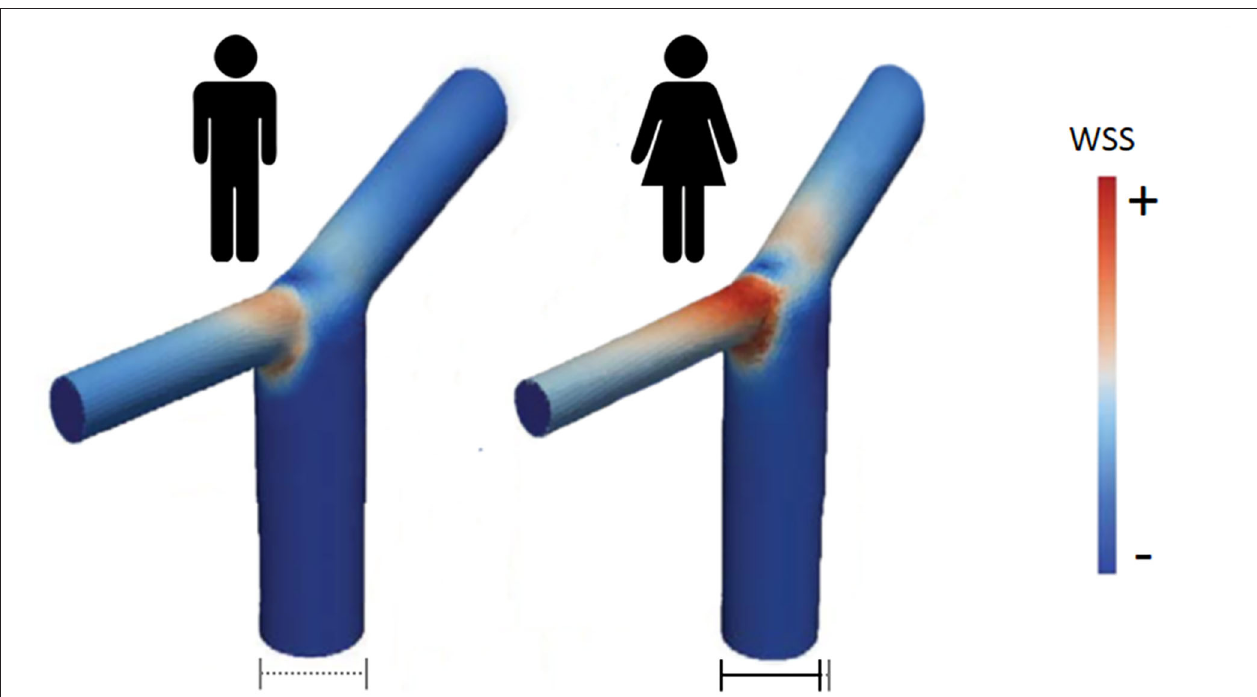
FIGURE 2 | Wall shear stress intensity in ICA bifurcation in men (left) and women (right). According to computational fluid dynamics simulations, area of high WSS is larger and of stronger intensity in women than in men [adapted from Lindekleiv et al. ( 41)].